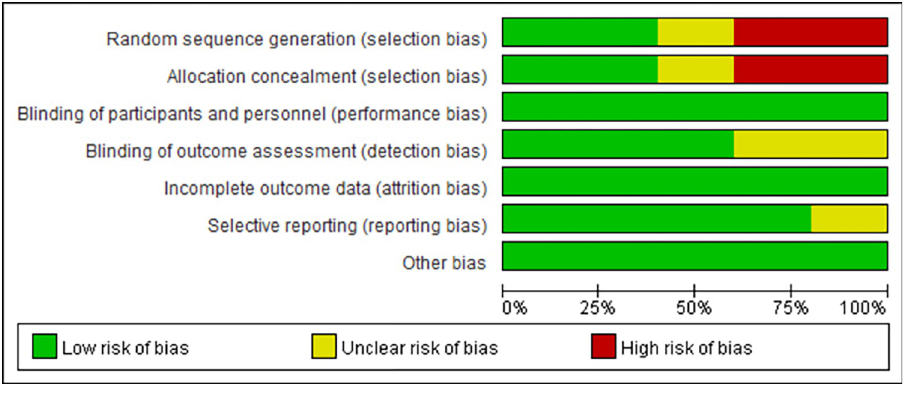
Fig 2. Risk of bias